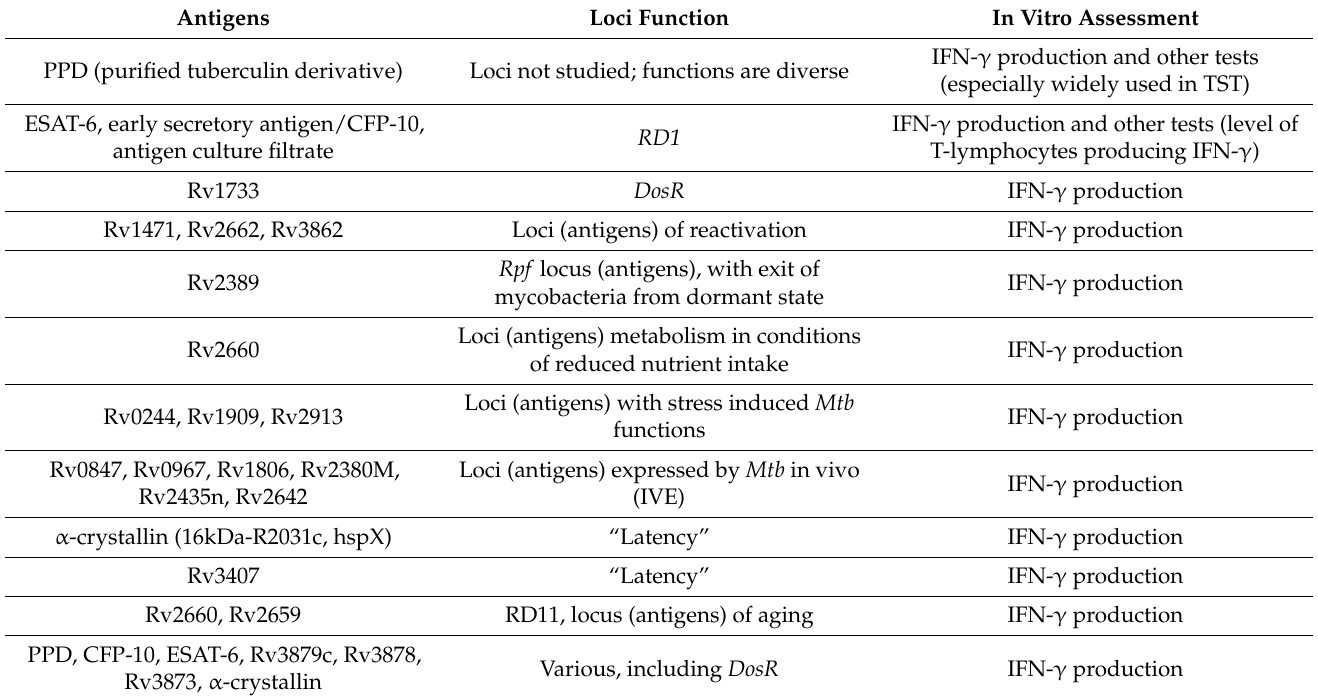
Table 1. Mtb antigens used to assess in vitro IFN- γ production for LTBI